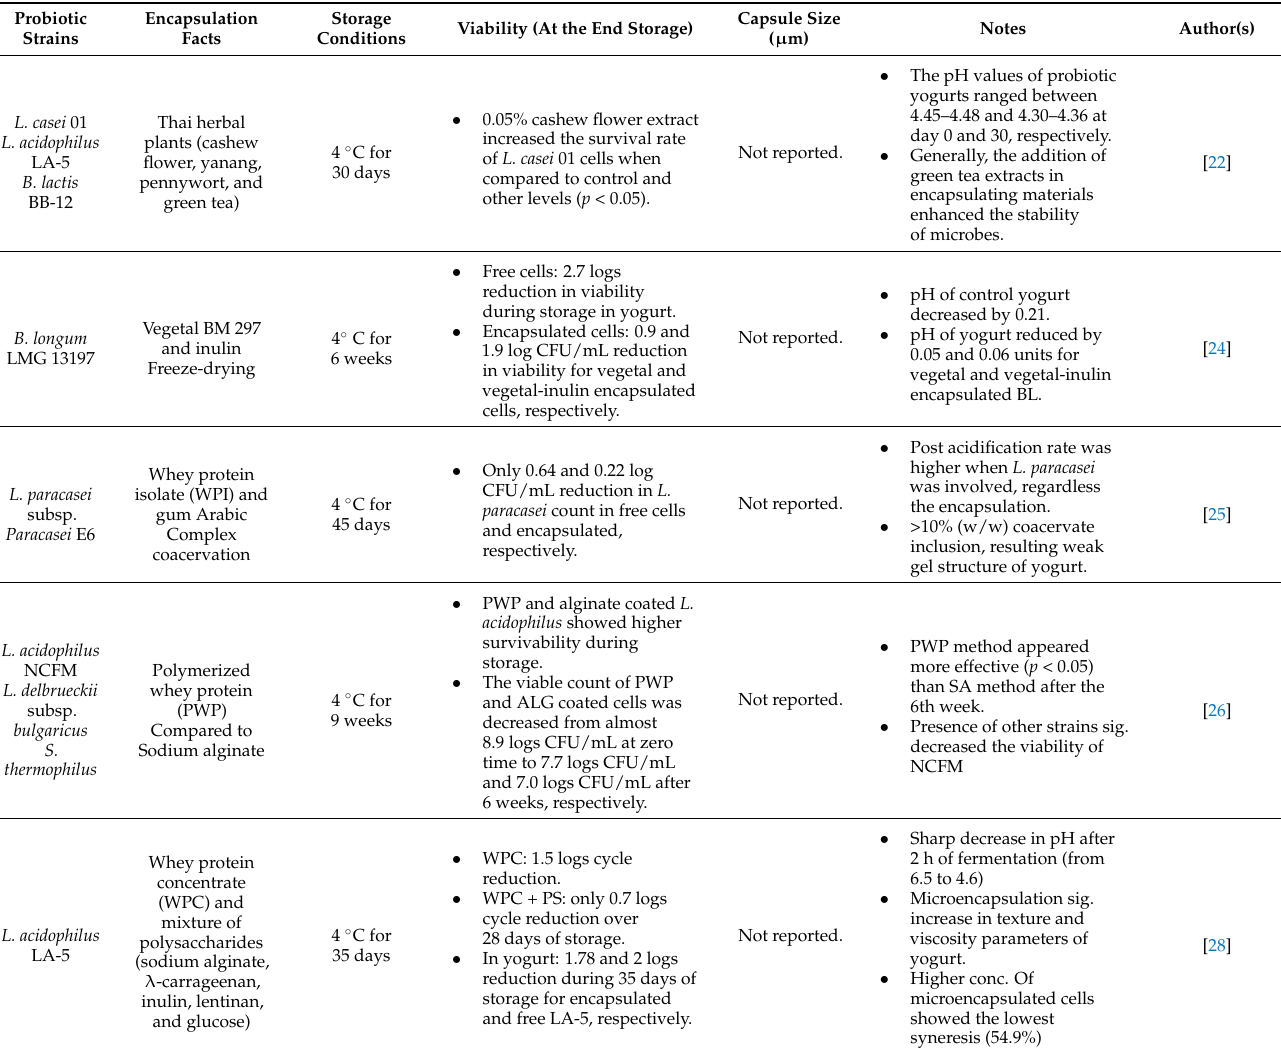
Table 1. Incorporation of microencapsulated probiotics into yogurt and cheese and its effect on viability during